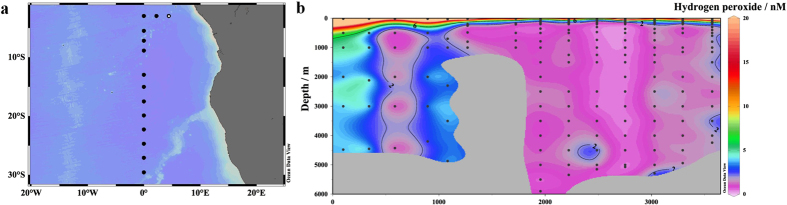
(a) GEOTRACES GA08 transect proceeding northeast-south in the South Atlantic, December 2015 (b) H2O2 concentrations in the South Atlantic plotted as distance along section shown (km) from northeast (left) to south (right). The first station (left) is marked on (a). Plotted in Ocean Data View54.